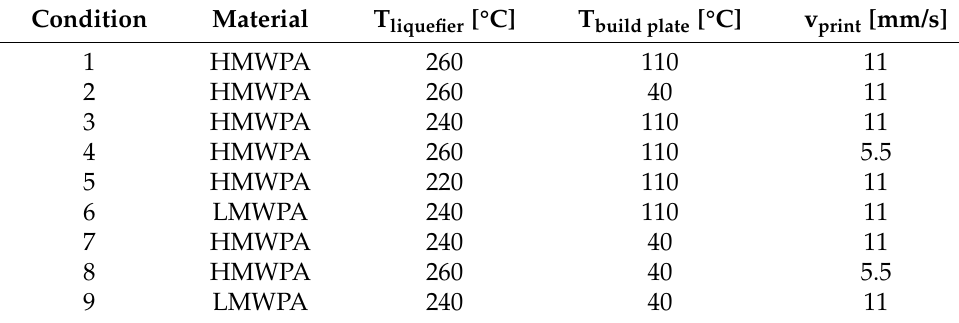
Table 2. An overview of the examined printing